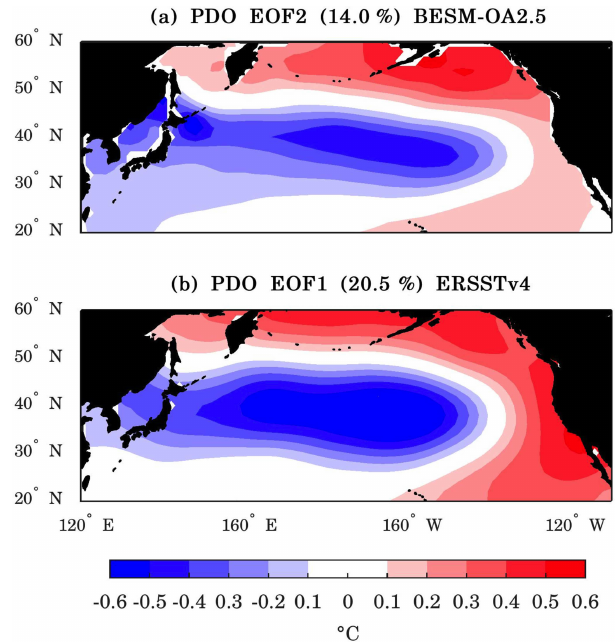
Figure 25. (a) The second EOF modes of monthly SST anomalies of BESM-OA2.5 and (b) the leading EOF mode of monthly SST anomalies of ERSSTv4, both over the North Pacific Ocean (20– 60 ◦ N, 240–110 ◦ W). The results are shown as the monthly SST anomalies regressed onto the corresponding normalized PC time se- ries (degrees Celsius per standard deviation) over the period 1900– 2005. The percentages of the variance explained by each EOF are indicated in the titles of the panels. The contour interval is 0.1 ◦